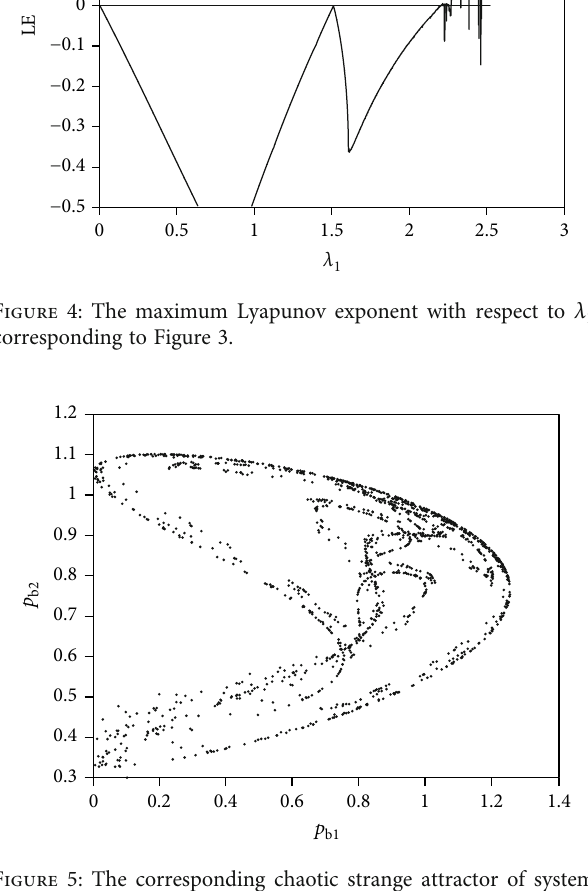
Figure 5: The corresponding chaotic strange attractor of system (23) when λ 1 = 2 : 522 .